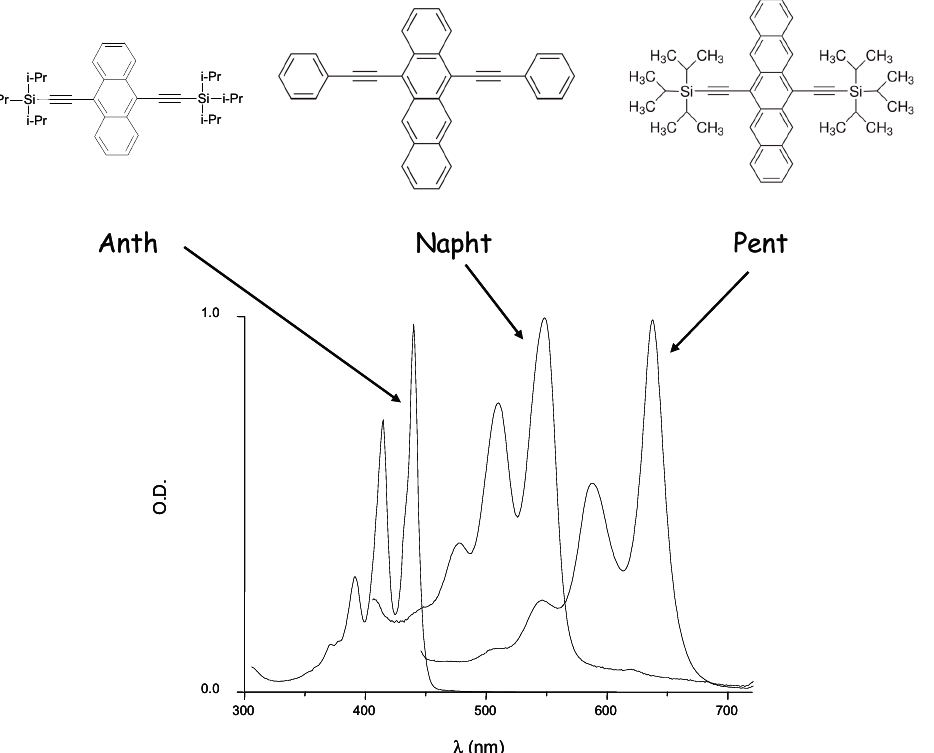
Figure 3. Visible light absorption spectra (O.D. for Optical Density) of different photoinitiators (Anth, Napht and Pent) in